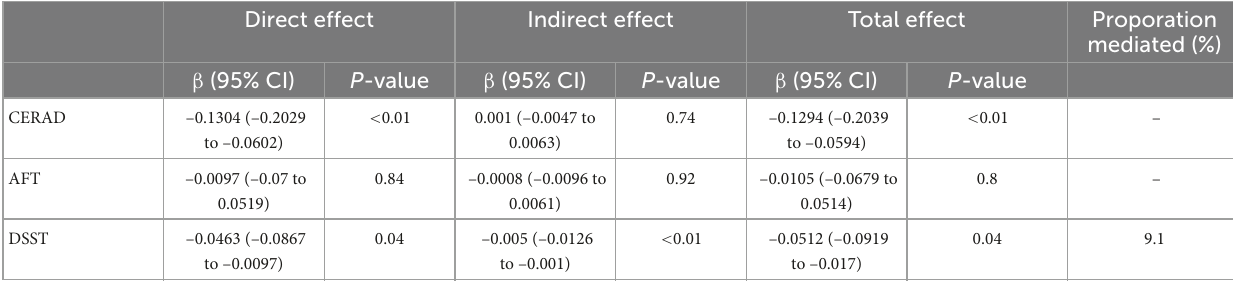
TABLE 8 The mediating proportion of mean AL on the association between α -tocopherol intake and low cognitive performance.